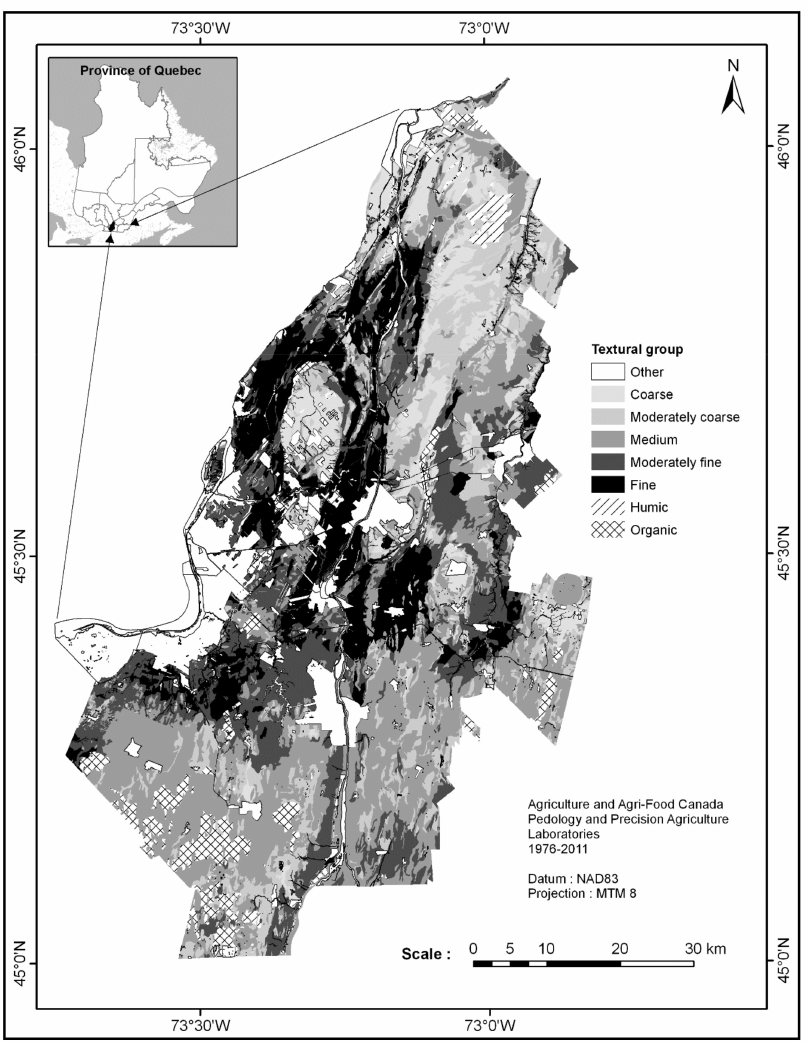
Figure 1. Map of the Monteregie soil surface textural